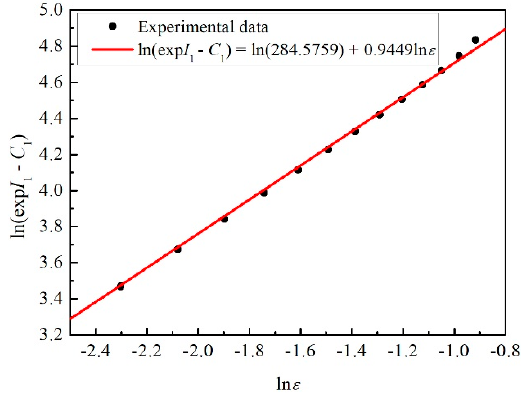
Figure 8. The relation between ln(exp I 1 − C 1 ) and ln ε .